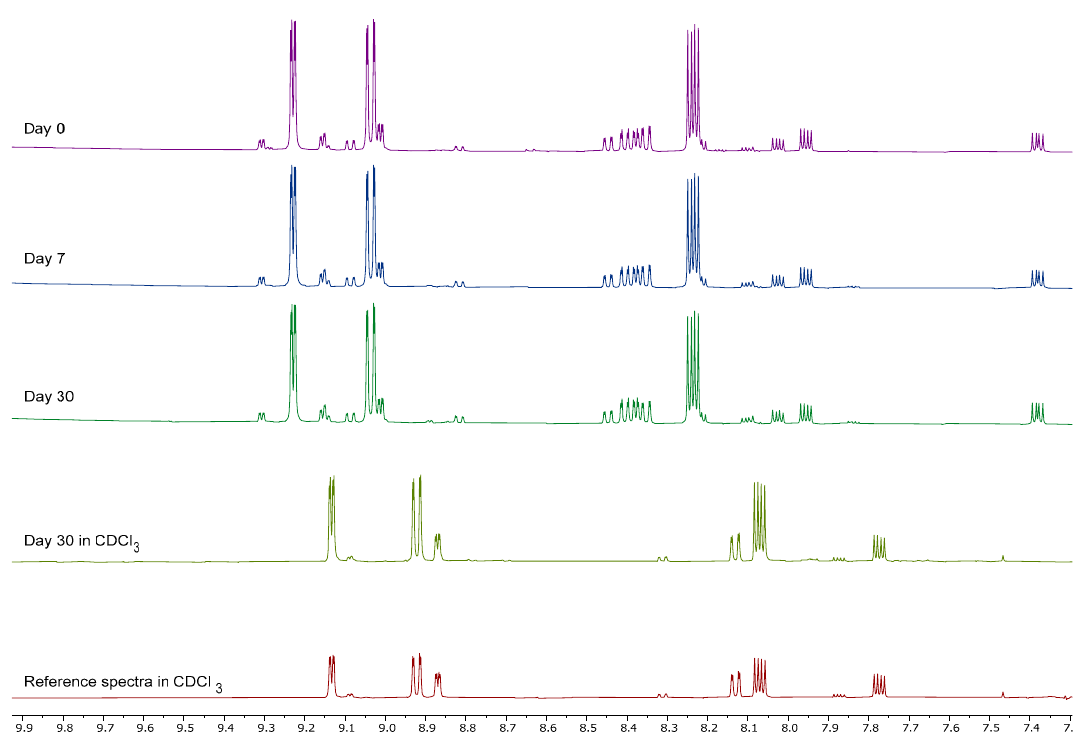
Figure 5. 1 H-NMR spectra of diazide 2 in AcOD- d 4 and CDCl 3 .